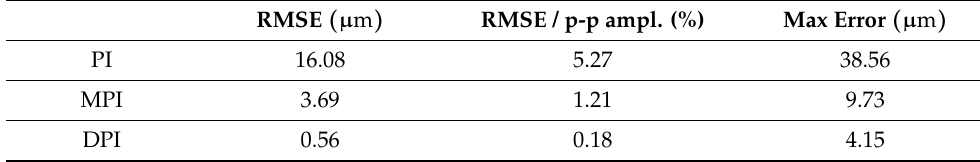
Table 1. Modeling experimental